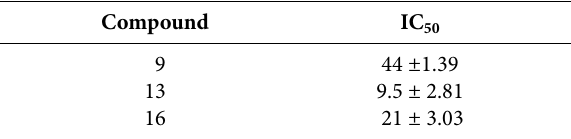
Table 2 IC 50 (μg/mL) of the more potent tested compounds on HCT-116 (colon adenocarcinoma) cell line.